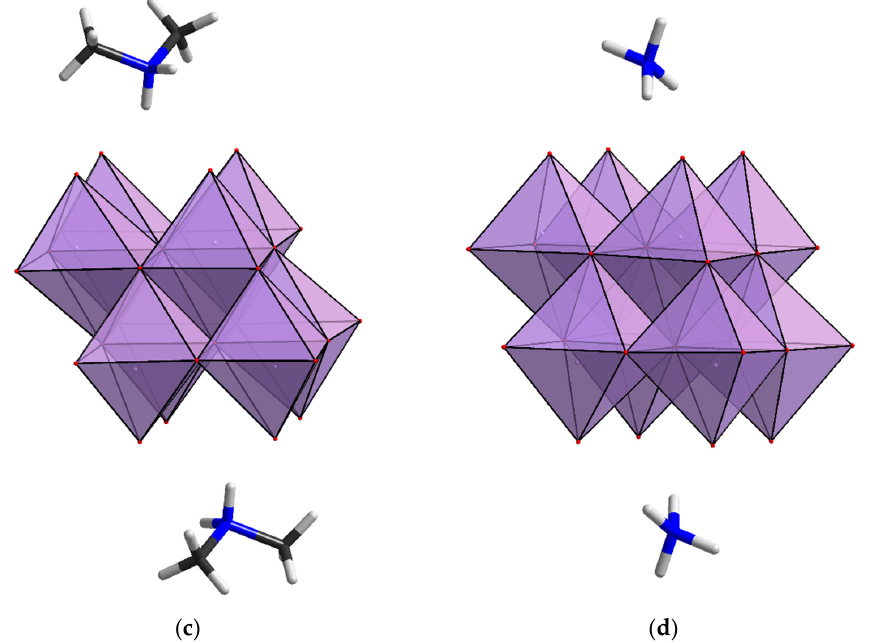
Figure 2. H…O=Mo interactions in the crystal structure of: ( a ) YAGNOJ; ( b ) BURBOH; ( c ) HIJSUR; ( d ) GISHEW.